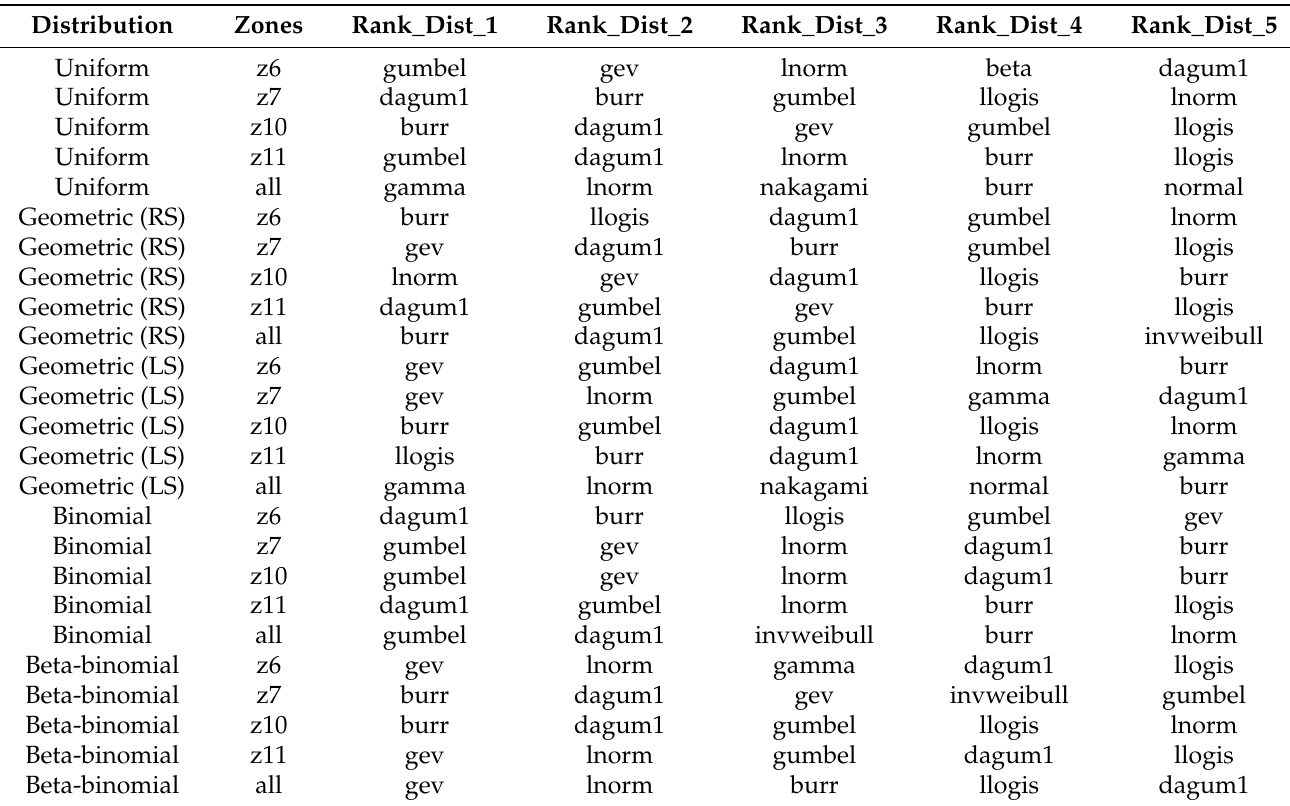
Table A2. Top five fitted distributions according to Anderson–Darling statistic on each of the four central zones and the entire assembly differentiated by the initial distribution of the rod